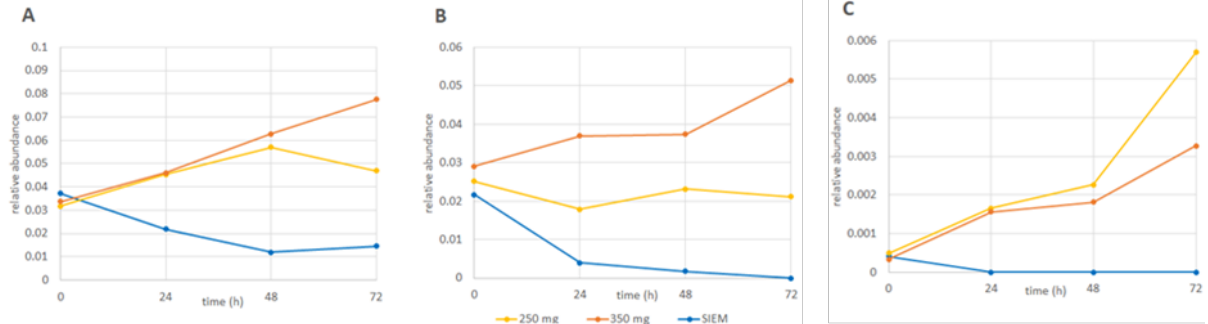
Figure 2. Relative abundance of ( A ) Enterococcus ; ( B ) Eubacterium ramulus ; ( C ) Bacteroides eggerthii ; ( D ) Roseburia ; ( E ) Lactobacillus mucosae, and ( F ) an uncharacterized species of the Bacteroidales S24-7 group after supplementation with standard ileal efflux medium (SIEM (control; blue)) or 250 mg (yellow) or 350 mg (orange) of Citrus Fruit Extract.